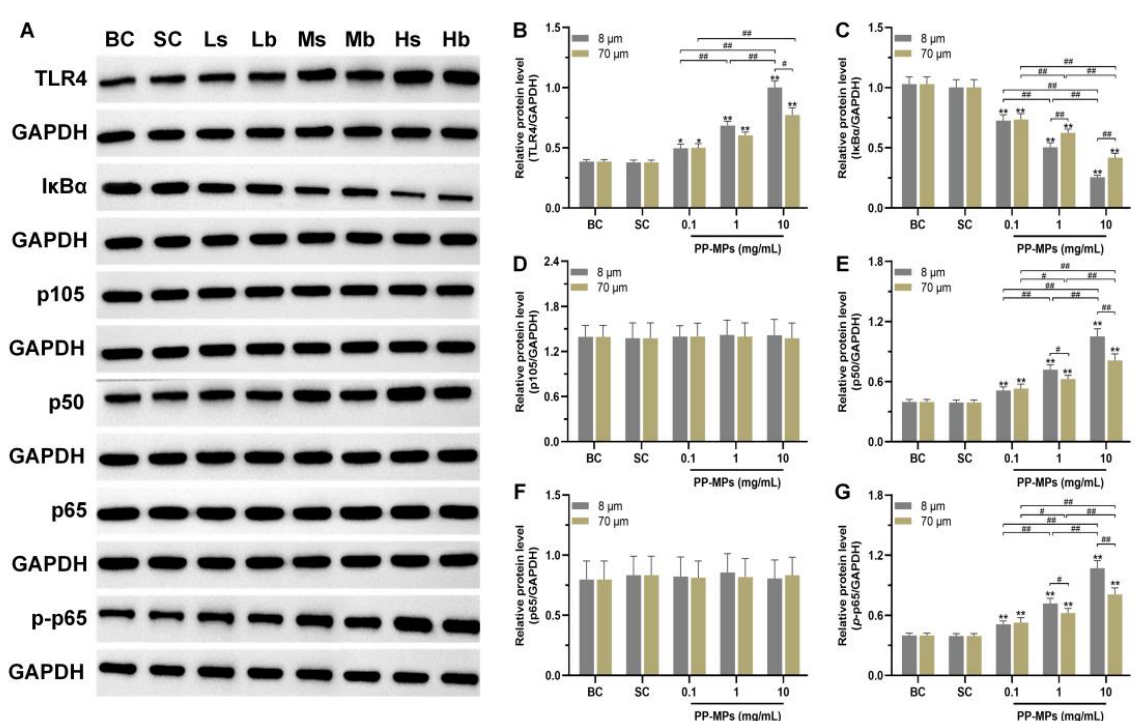
Figure 4. Effects of PP-MP exposure on protein expression of the TLR4/NF- κ B signaling pathway. ( A ) Western blot of TLR4, p105, p50, p65, p - p65, and IκBα protein expression. GAPDH was used as